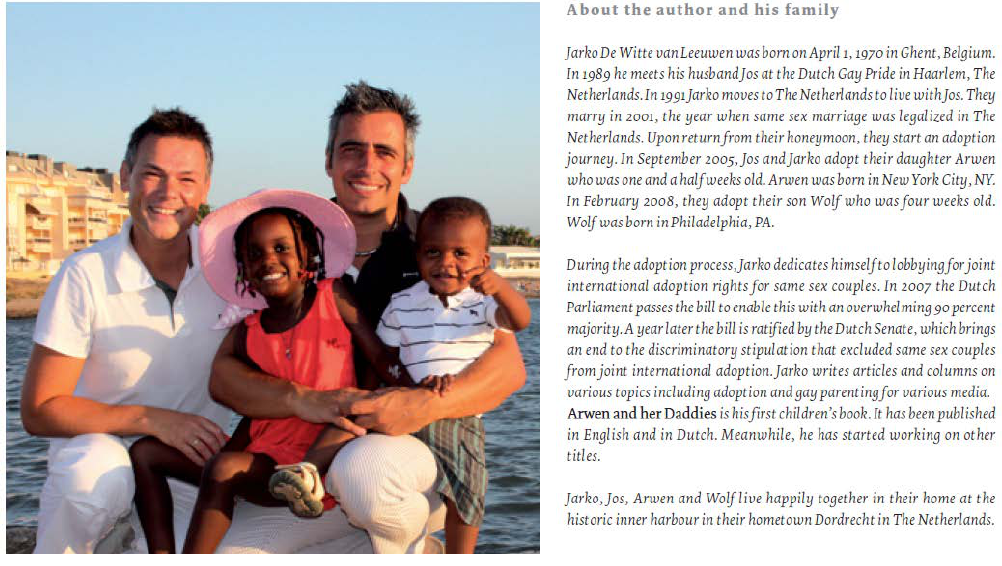
Figure 14. The flap text features a picture of the author’s family, including Arwen.